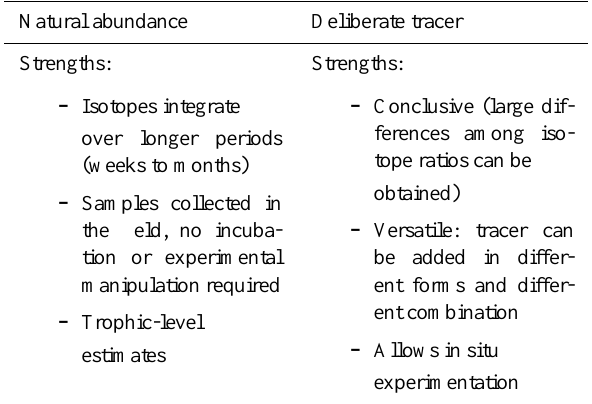
Table 1. Strengths and weakness of deliberate tracer and natural abundance stable isotope